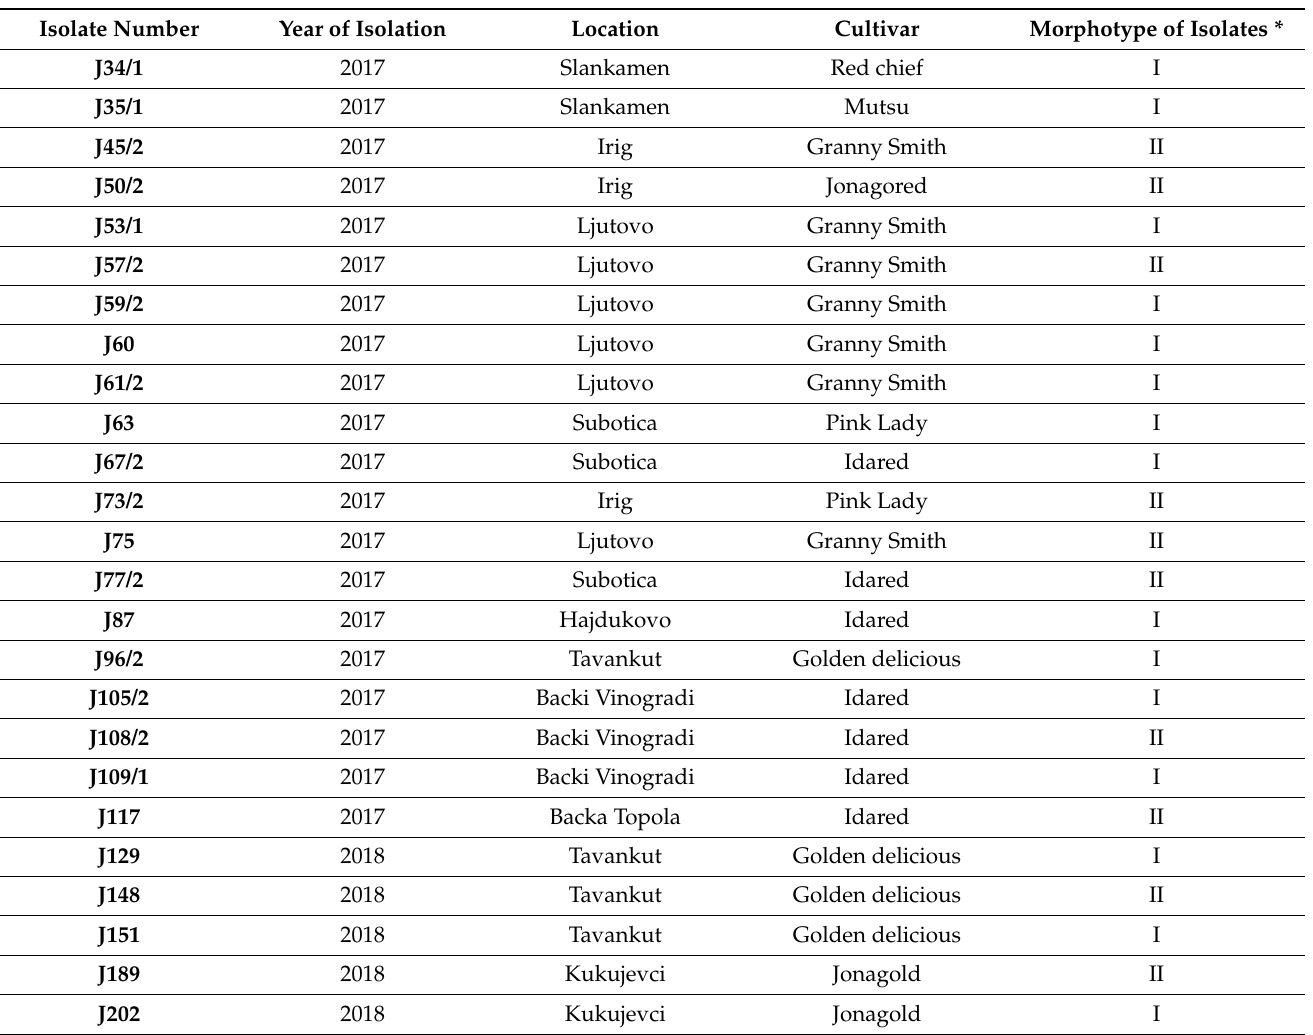
Table 4. Identified Neofabraea sp. isolates from Serbia, including information on the location, host, cultivar, and morphotype of each